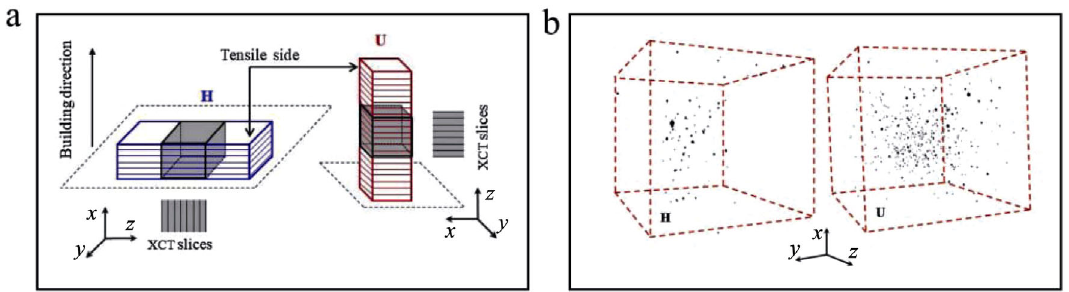
Fig. 39 (a) Schematic representation of the horizontal (H) and upright (U) architectures showing the orientation of the material layers in relation to the tensile side and the direction, z , of XCT scans completed over a length of 10 mm at the center of the specimens (colored area). (b) 3D XCT reconstructions showing the pore distribution in H and U samples (observation volume: 2.2 mm × 2.5 mm × 2.5 mm). Reproduced with permission from Ref. [105], © Elsevier Ltd.